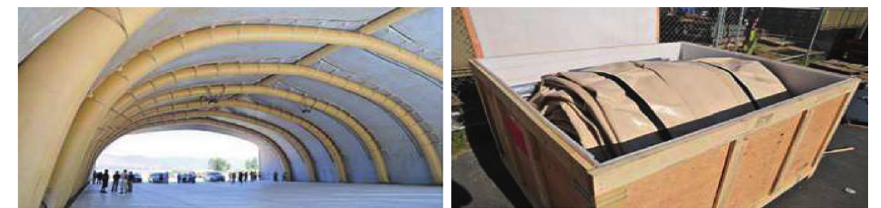
Figure 5: Flexible composite pressurized air beams and shipping container [19].